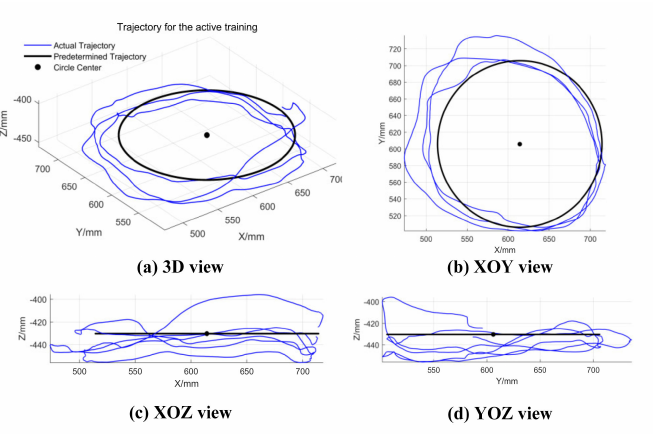
Figure 17. The trajectory of the subject’s hand during the active testing. ( a ) A 3D view of the trajectory; ( b – d ) XOY, XOZ, and YOZ view of the trajectory, respectively.